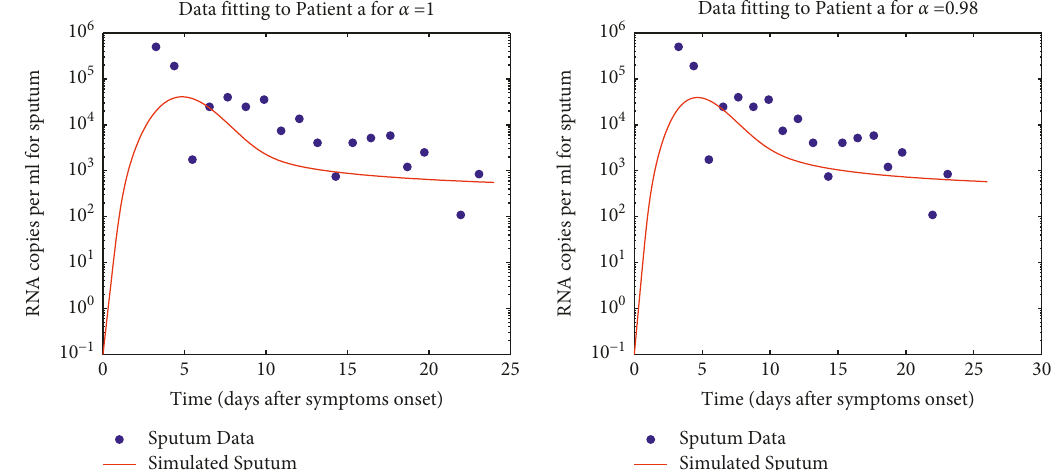
Figure 5: Data fitting for patient g